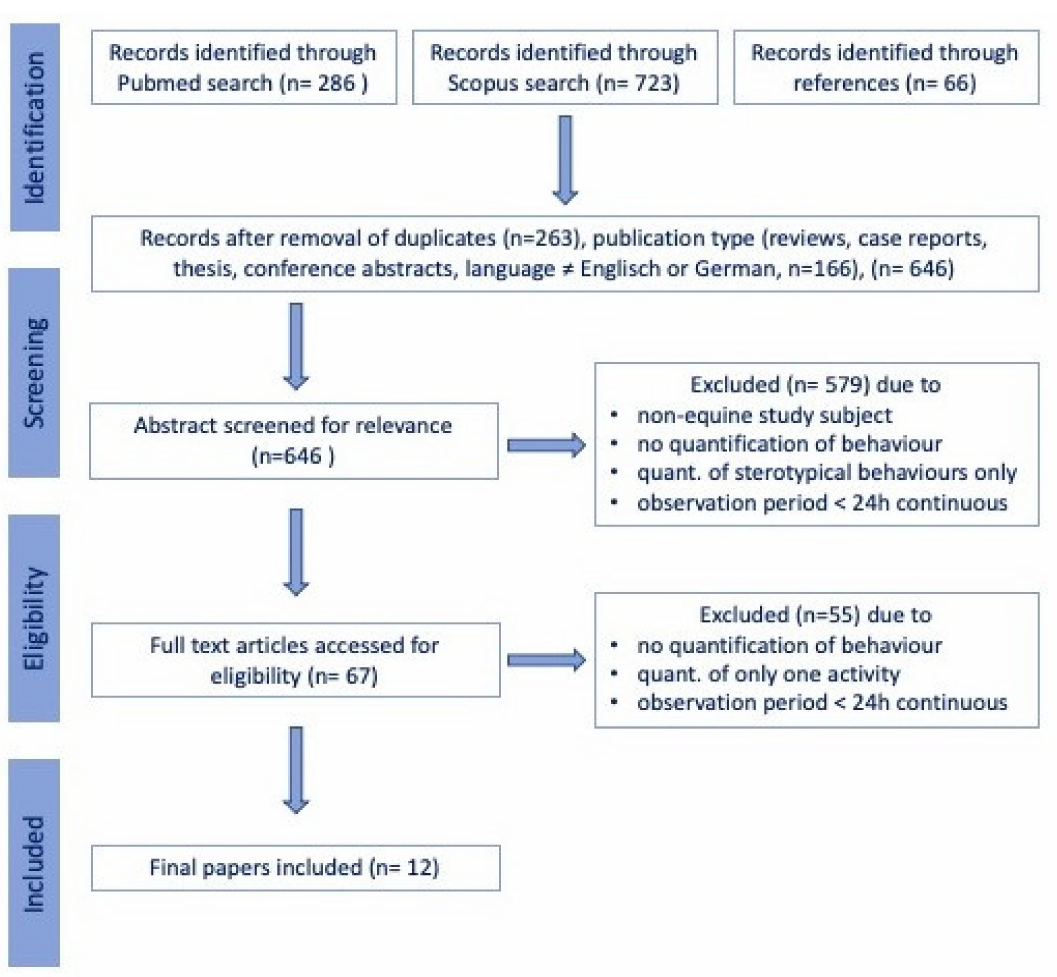
Figure 1. Flow chart illustrating the selection of studies included in the